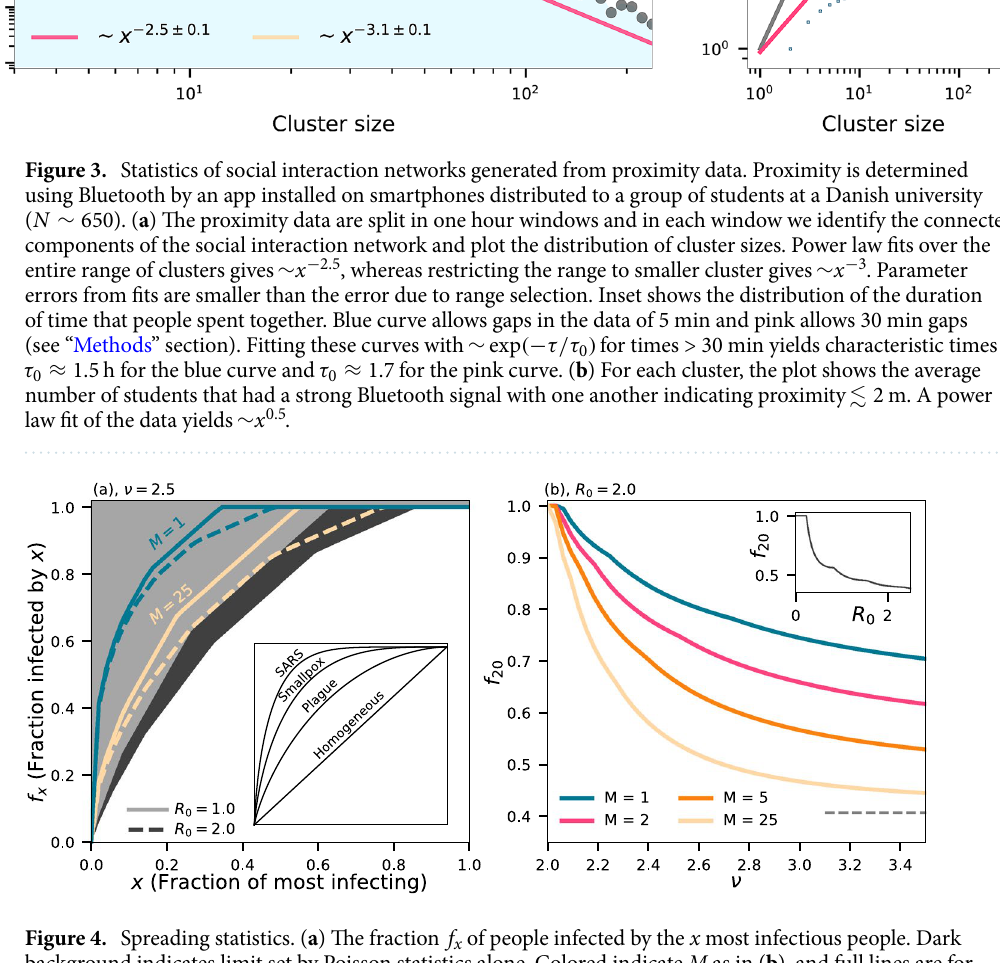
2.5 as it varies with =